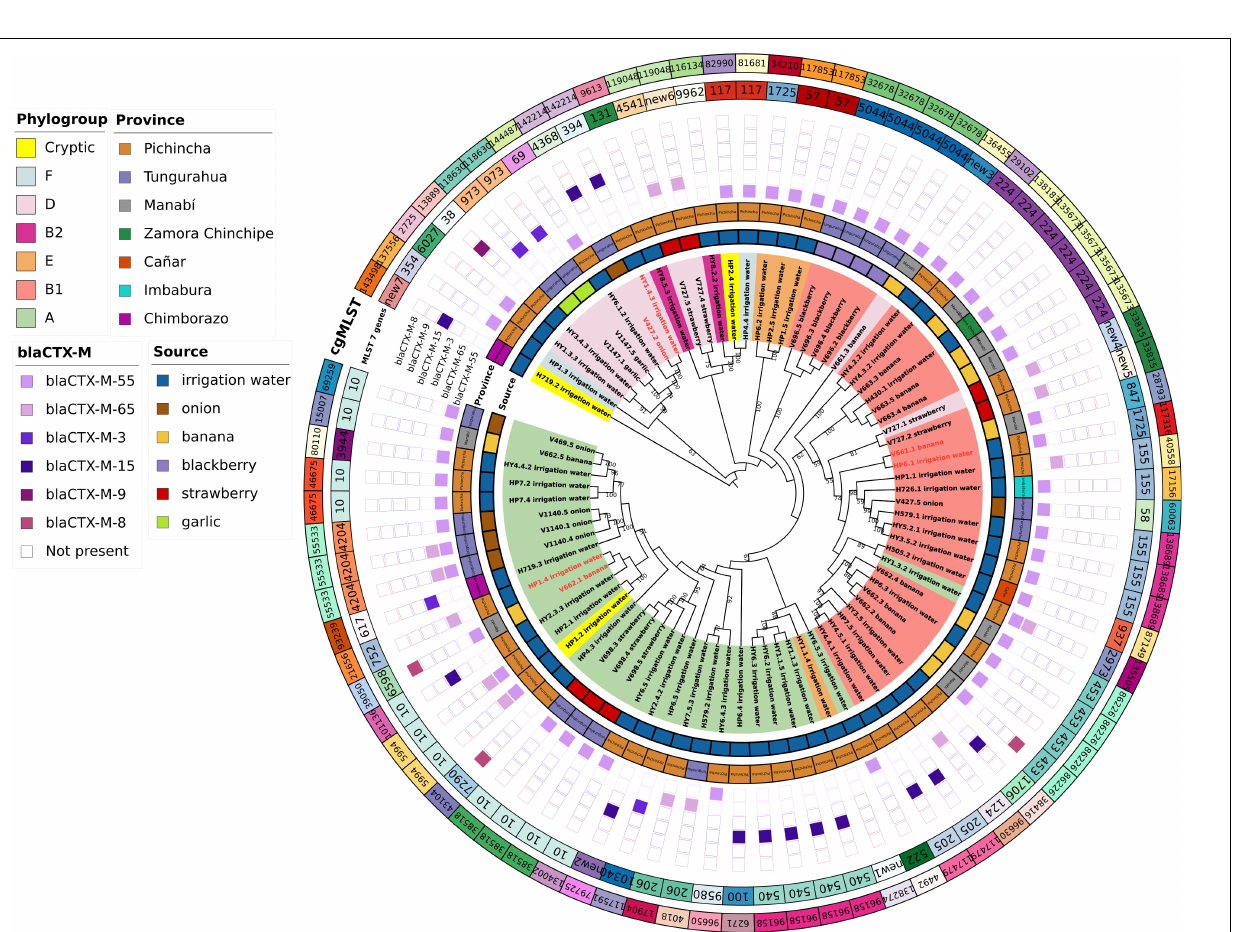
FIGURE 2 | Frequency of allelic variants of AMR genes in E. coli from different